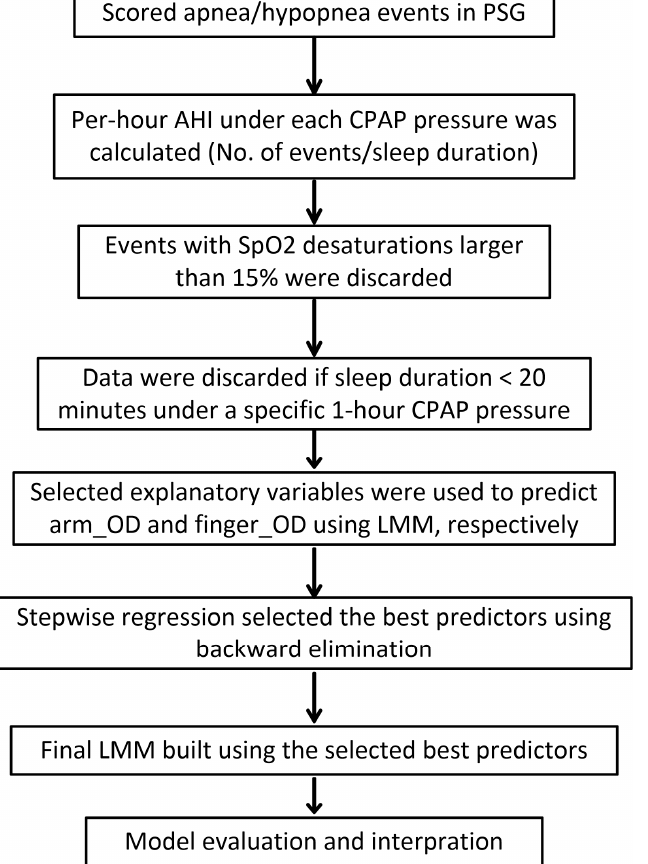
Figure 1. Data analysis procedure. Data were expressed as the mean ± SD unless otherwise indicated. The pre-processing of FDMD-NIRS signals was carried out in MATLAB (The MathWorks, Inc., Natick, MA, USA). All statistical analyses were performed using R (version 3.2.4). The LMM models were created using the R package lme4 (function lmer ) and stepwise regressions were performed using the R package lmerTest (function step